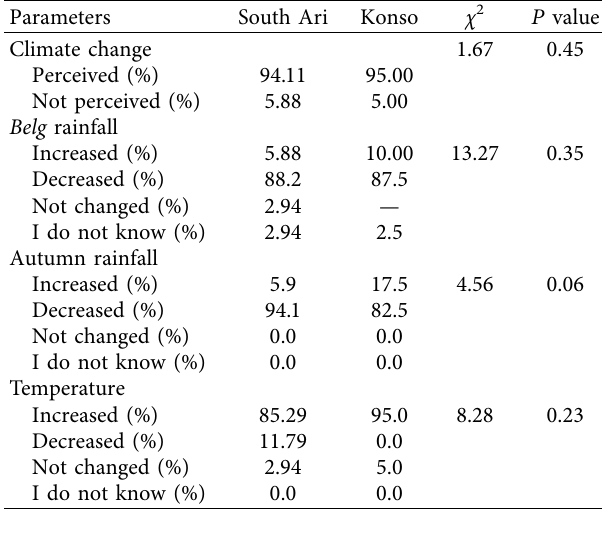
Table 2: Trends of changes in Autumn and Kiremt rainfall of weather stations in Southwest Ethiopia for the period 1983–2016.